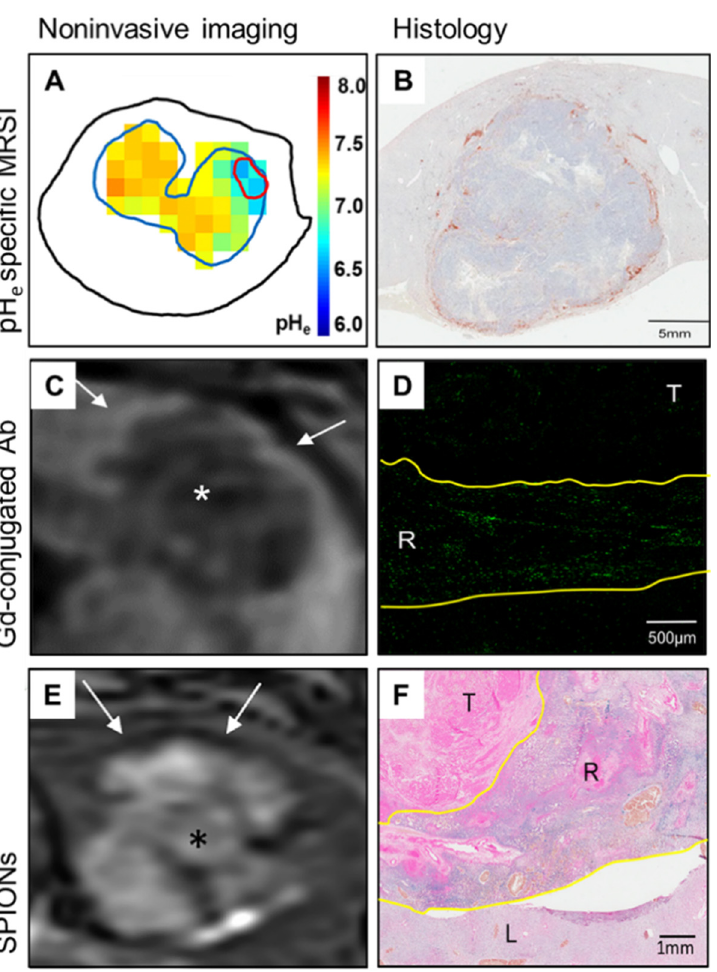
Figure 2. Imaging of the immuno-metabolic crosstalk in a translational rabbit liver tumor model. (A) Non-invasive quantitative mapping of the extracellular pH (pH e ) using pH e -specific magnetic resonance spectroscopy imaging (MRSI) reveals significantly lower tumor pH e as compared to the liver parenchyma. (B) Immunohistochemistry staining of HLA-DR on antigen-presenting cells demonstrates peritumoral immune cell clusters and lacking intratumoral infiltration. (C) T1-weighted MR imaging (MRI) after the injection of gadolinium (Gd)-conjugated HLA-DR antibodies (Ab) shows corresponding peritumoral rim enhancement in vivo. (D) Ex vivo imaging mass cytometry confirms localization of the labeled immune cells in the peritumoral rim in green, (E) T2-weighted MRI with superparamagnetic iron oxide nanoparticles (SPIONs) demonstrates hypointense signal indicative of macrophage infiltration in the peritumoral rim. (F) Ex vivo Prussian blue staining confirms corresponding iron deposition in the peritumoral rim. T, tumor; R, tumoral rim; L, liver parenchyma; white arrows, signal alterations at the tumoral rim; *, tumor. Adapted and modified from [34].